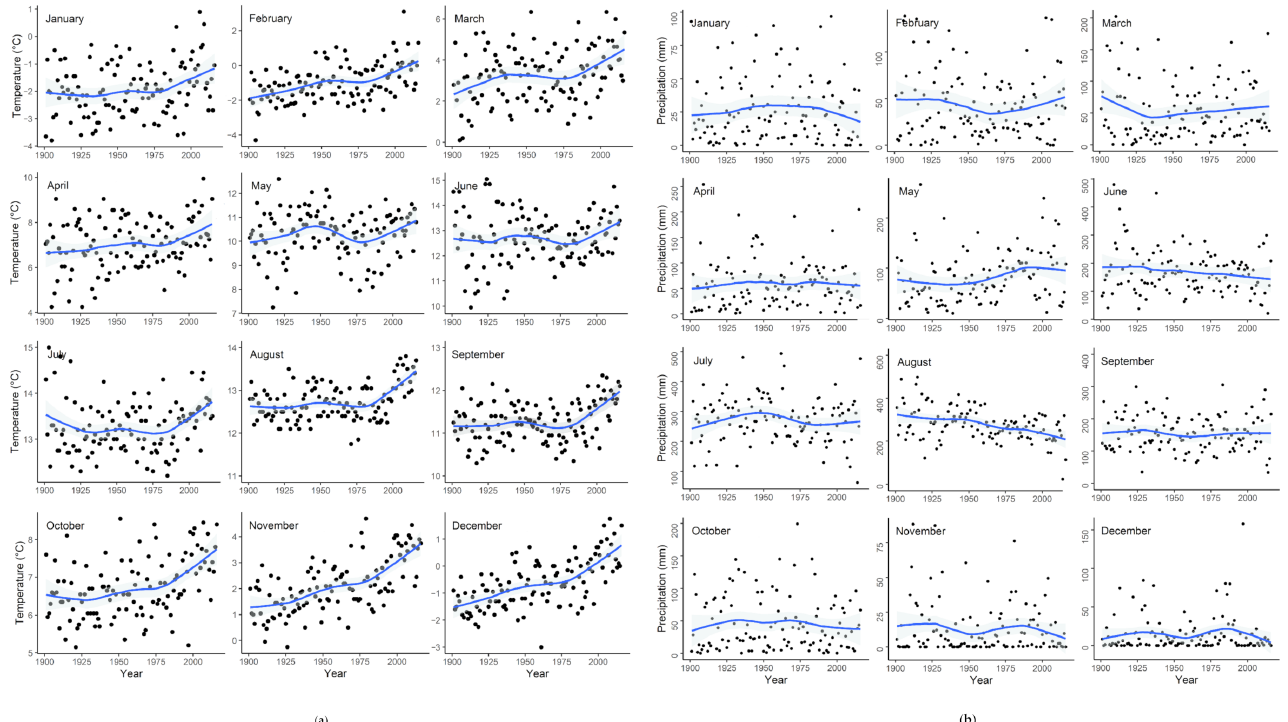
Figure A1. ( a ) Monthly mean temperature based on the CRU gridded dataset 1901–2019. The blue lines are the LOWESS smoothing, gray shades are 95% confidence interval. ( b ) Monthly sum of precipitation based on the CRU gridded dataset 1901–2019. The blue lines are the LOWESS smoothing, gray shades are 95% confidence